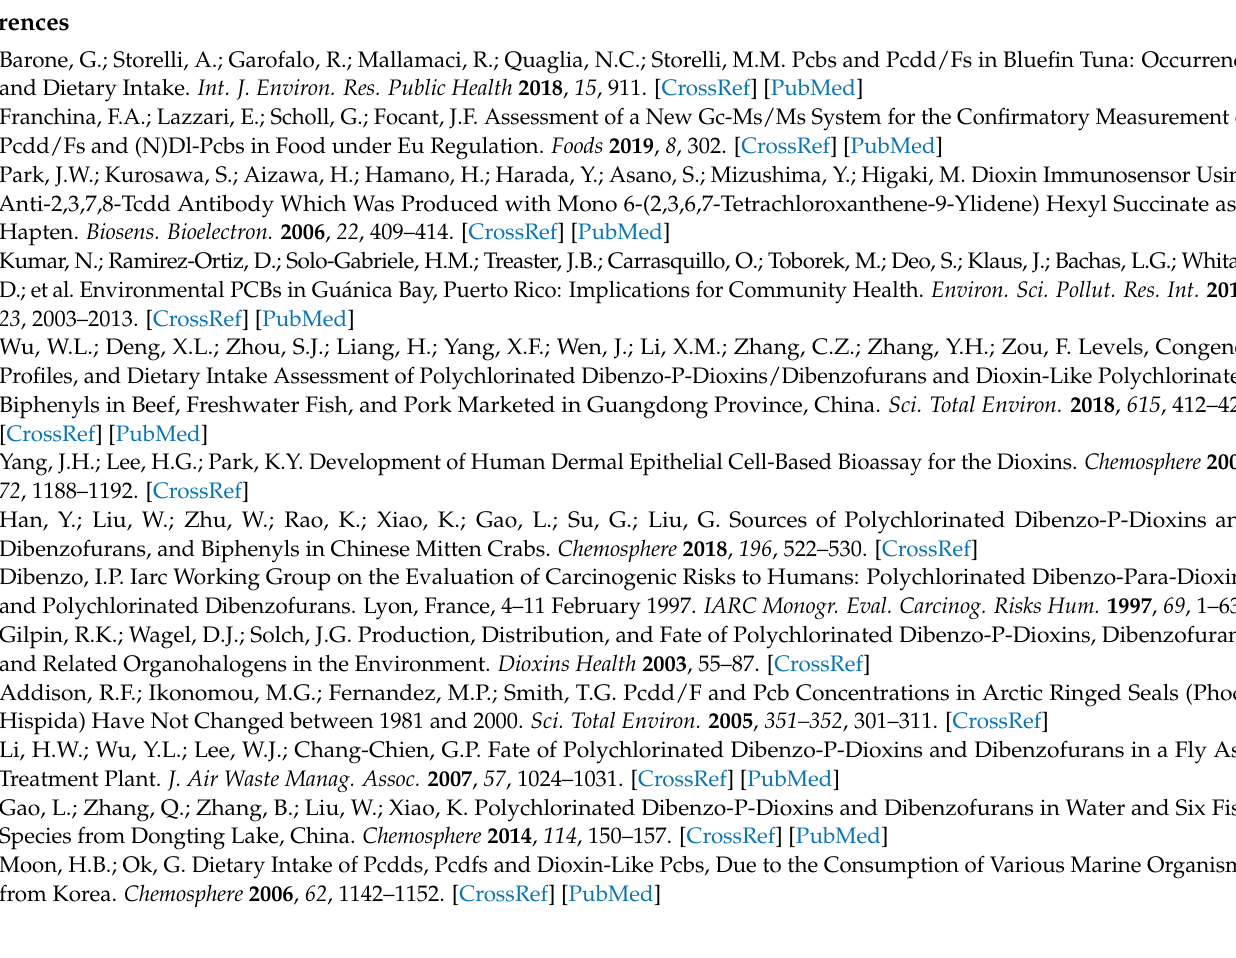
Table S2: Summary of 29 compounds and WHO 2005 TEF Values, Table S3: Solutions of isotopically labelled quantitative internal standards for PCDD/Fs and DL-PCBs, Table S4: Solutions of isotopically labelled recovery internal standards for PCDD/Fs and DL-PCBs, Table S5: The concentrations of PCDD/Fs and DL-PCBs in Chinese mitten crabs and the potential sources, Table S6: PCDD/F and DL-PCB TEQs in Chinese mitten crabs from fresh markets, Table S7: The total PCDD/F and DL-PCB TEQs in Chinese mitten crabs and the potential sources, Table S8: The concentrations of PCDD/Fs and DL-PCBs in market crabs, Table S9: The total PCDD/F and DL-PCB TEQs in in the soil around Qingpu and Chongming district farms, Table S10: Informed detection limit (DL) of the method and the percentage of recovery of each PCDD/F and DL-PCB congener analyzed. Figure S1: Ratios of DL-PCBs/PCDD/Fs in farm Chinese mitten crabs and potential